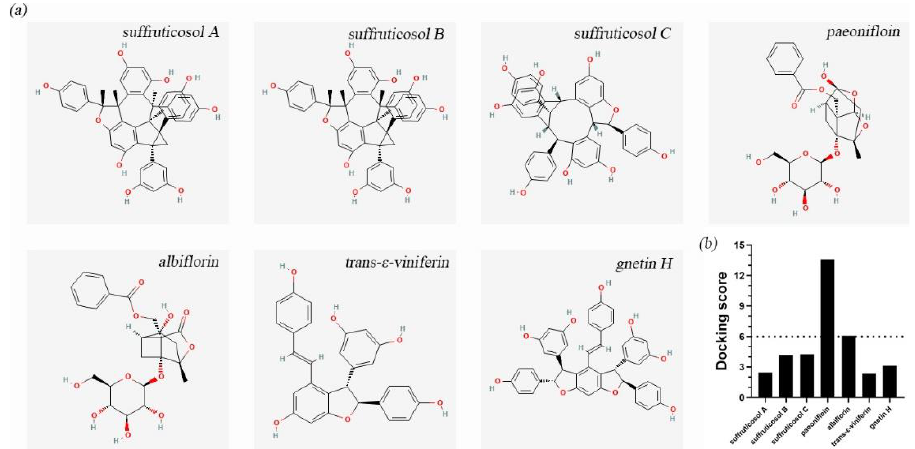
Figure 6. Interactions between each peony seed cake extract on LuxS. ( a ) 2D structure of each peony seed cake extract. ( b ) The binding fraction of each peony seed cake extract and LuxS protein, The dashed line indicates the lowest binding fraction.